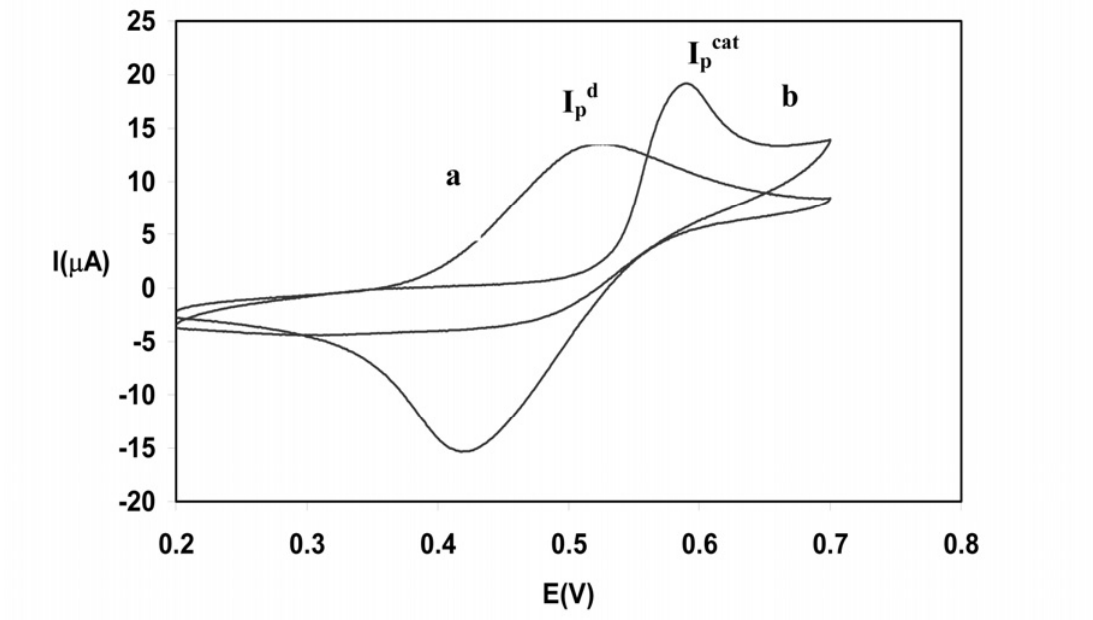
Figure 3. Cyclic voltammograms of 1×10 -3 M sodium iodide: (a) in the absence and (b) in the presence of 1×10 -3 M o-cresol, at GC electrode in aqueous solution containing 0.2 M acetate buffer (pH 4.8), scan rate, 20 mVs -1